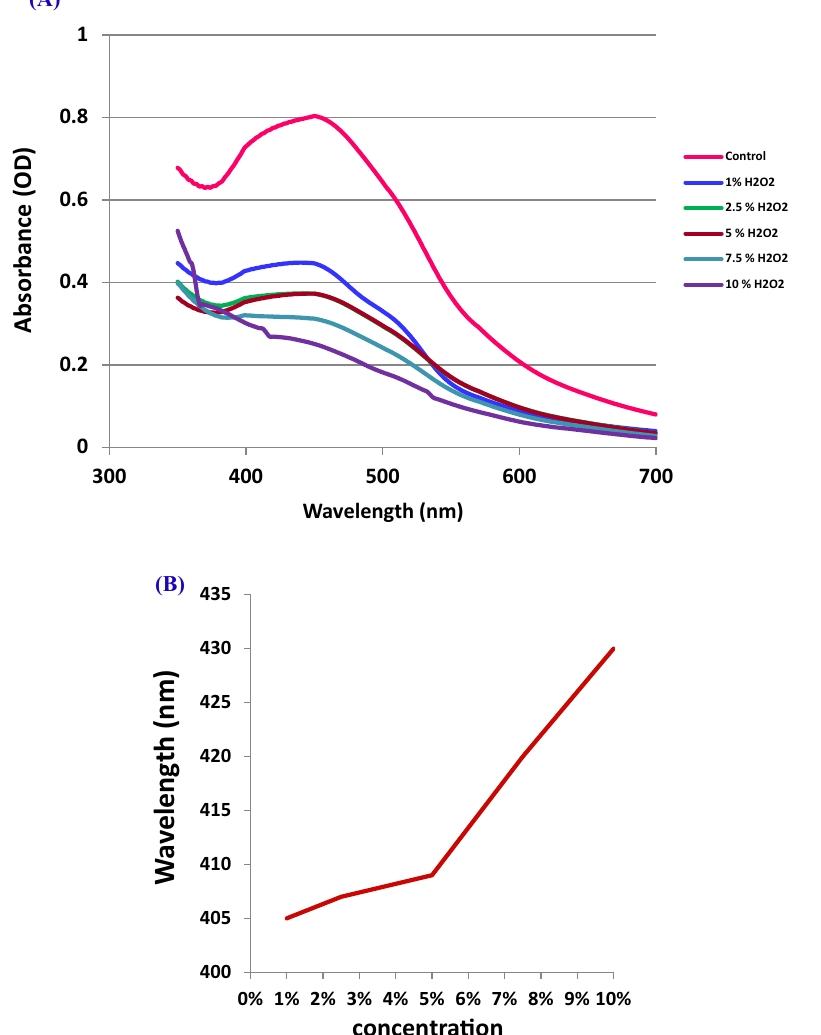
Figure 11. Change in SPR peak position after the introduction of H 2 O 2 solution with different concentration to OG-AgNPs solution at a volume ratio 1:1.5 ( A ) and ( B ) figure of H 2 O 2 concentration against the SPR peak